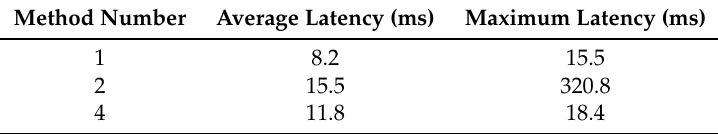
Table 7. The latency comparisons for the different